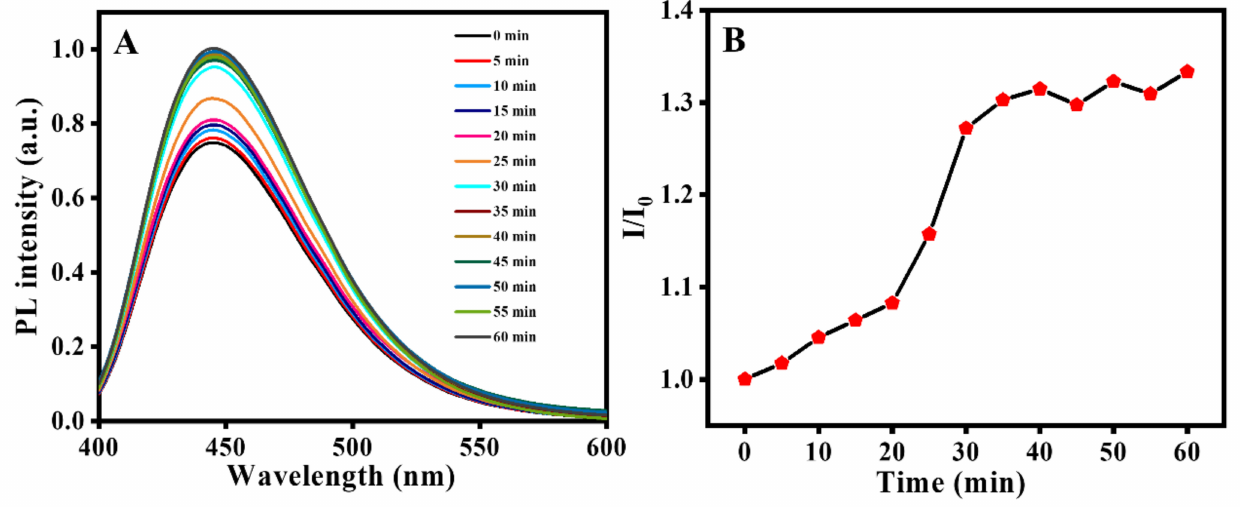
Figure 7. ( A ) Fluorescent intensity and ( B ) relative intensity (I/I 0 ) of the NPCD-MnO 2 composite with GSH (20 µ M) over time.